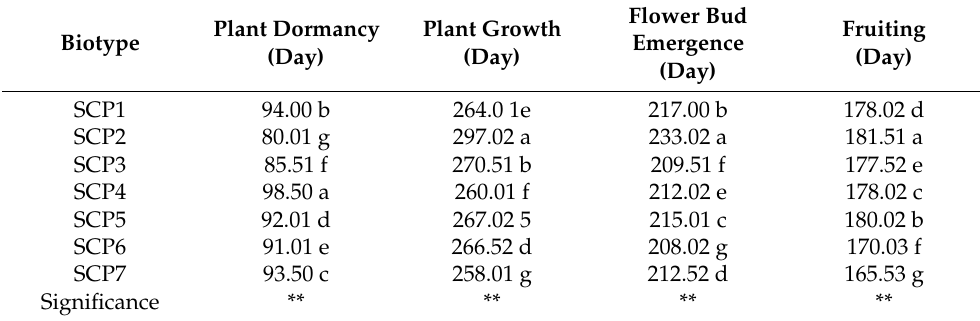
Table 7. Average length of phenological stages based on accessions of C . spinosa subsp. rupestris